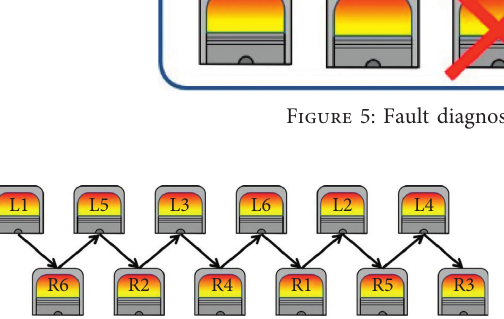
Figure 6: The firing order of 12-cylinder diesel engine.